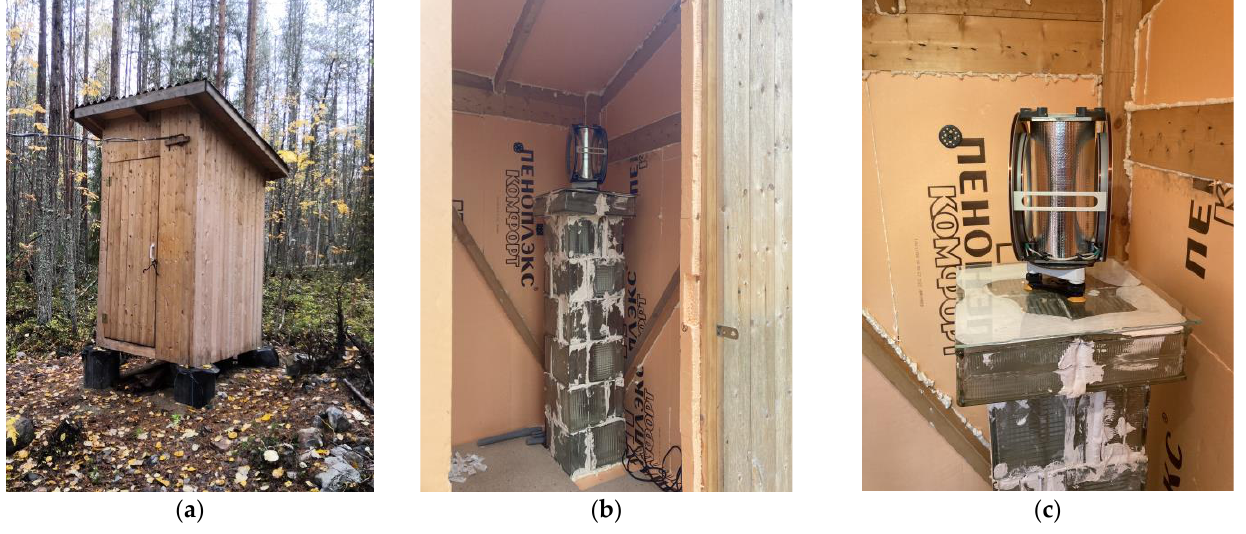
Figure 2. The White Sea observatory magnetometer pavilion: ( a ) General view of the building; ( b ) Interior; ( c ) The vector Overhauser magnetometer POS-4 installed in the pavilion.